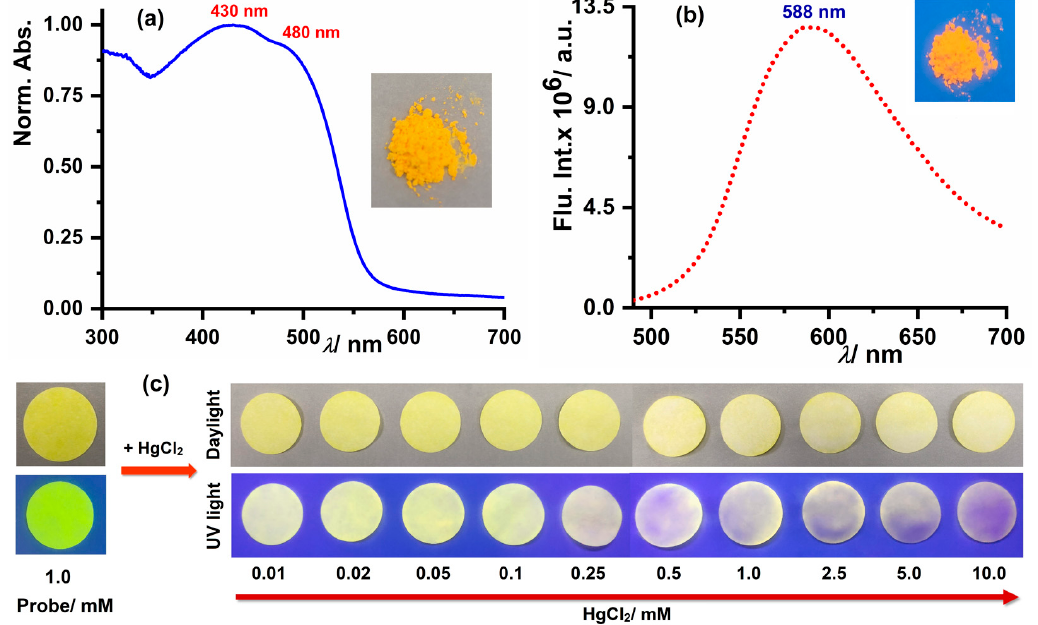
Figure 5. Solid-state ( a ) UV–Vis. absorption and ( b ) emission spectra of His-NMI-Bu ; insets show the images of the solid sample (powder) under daylight and UV light illumination ( c ) representation of emission color change in the filter papers before and after the addition of HgCl 2 dissolved in Milli- Q H 2 O with different concentrations. Left: probe only and right: probe + HgCl 2 .